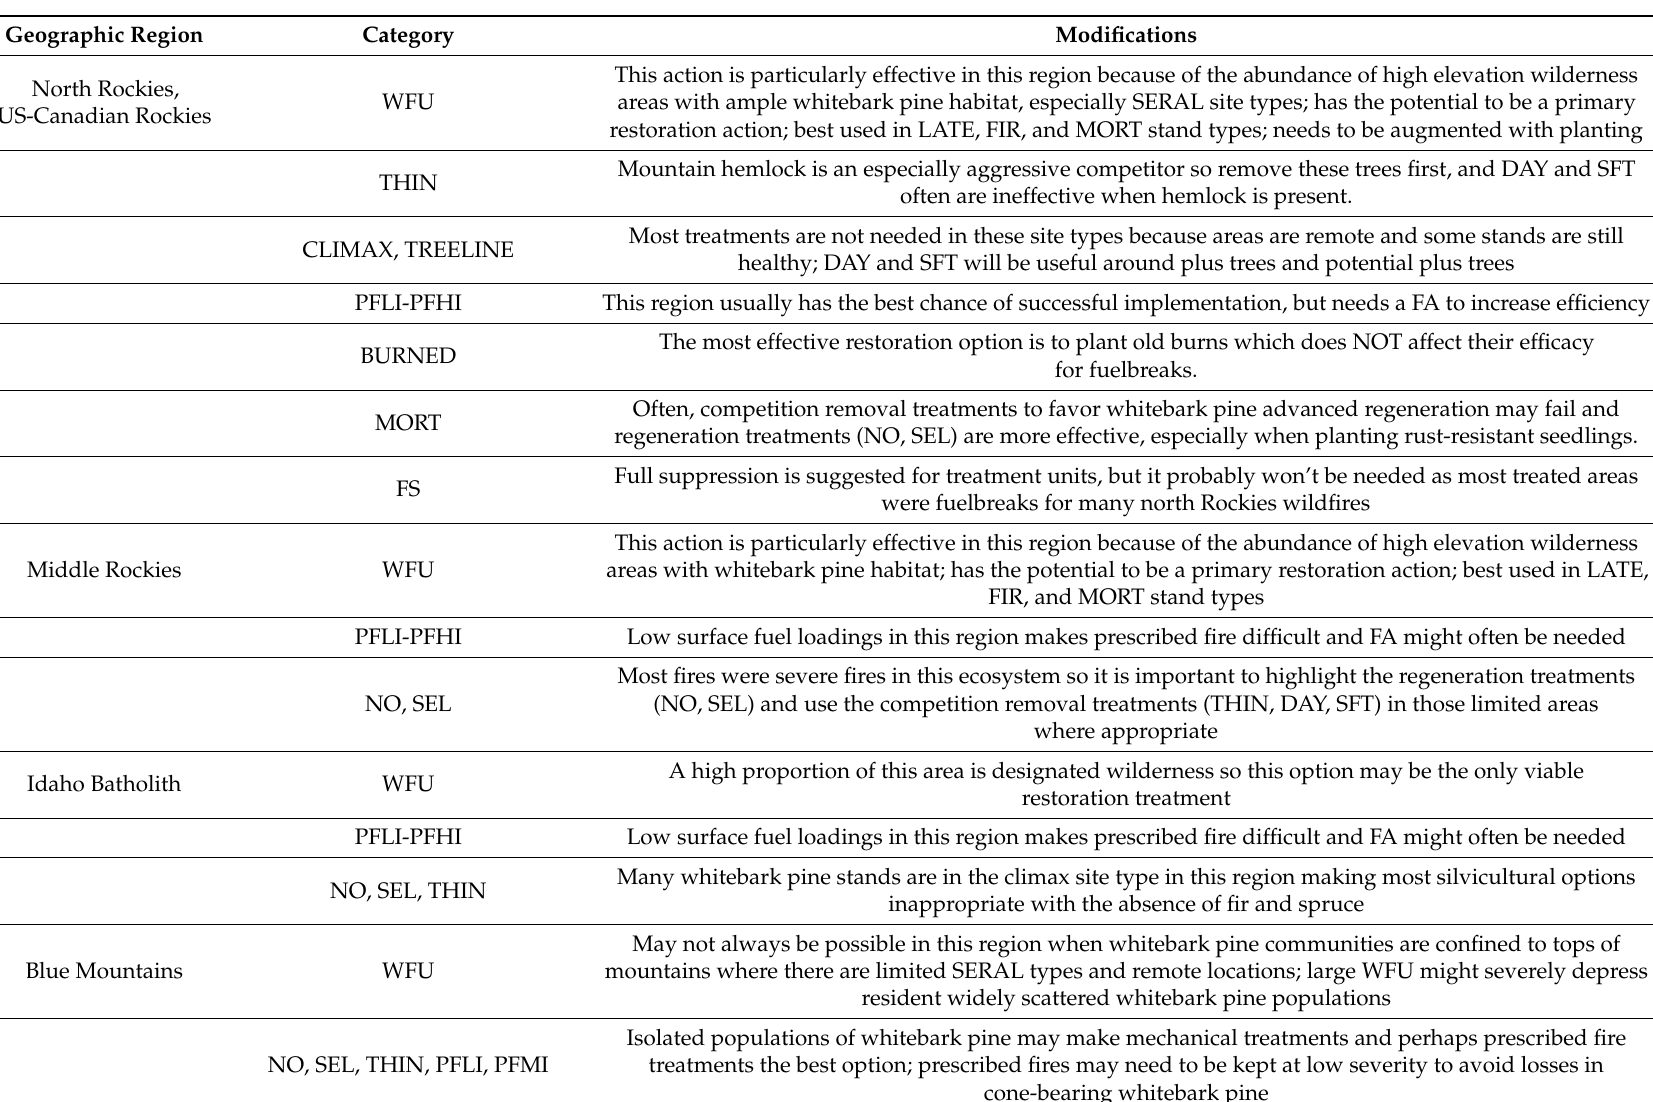
Table 3. Modifications and notes of wildfire management actions for whitebark pine restoration presented in Table 1 for each geographic region (Figure 2). Geographic